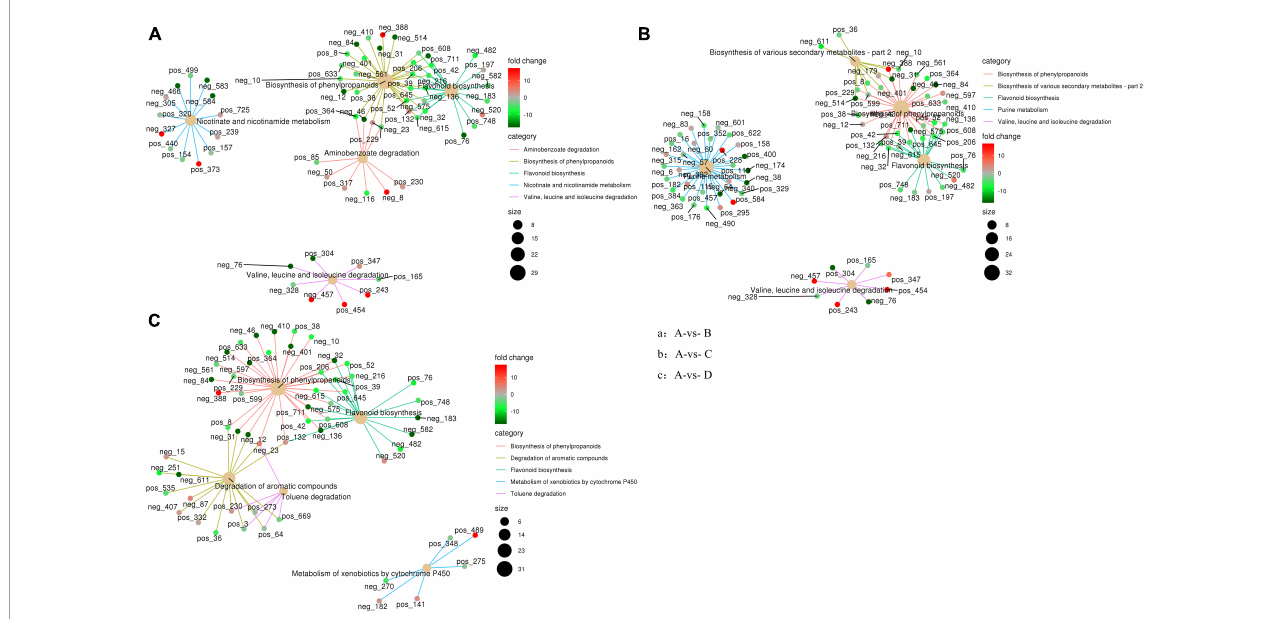
FIGURE4 Enrichment network diagram of differential metabolites in IDTs. Pictures respectively represent metabolites pathways between IDT produced by blsnk control and IDTs fermented by fungi. The light-yellow node refers to the associated metabolic pathway, and its size of it indicates the number of metabolites included by these pathways. The dots connected with the node refer to the specific metabolites annotated to the pathway, along with the color depth indicating the difference multiple taking the value of log 2. The different fermentation treatments of instant dark tea were the blank control